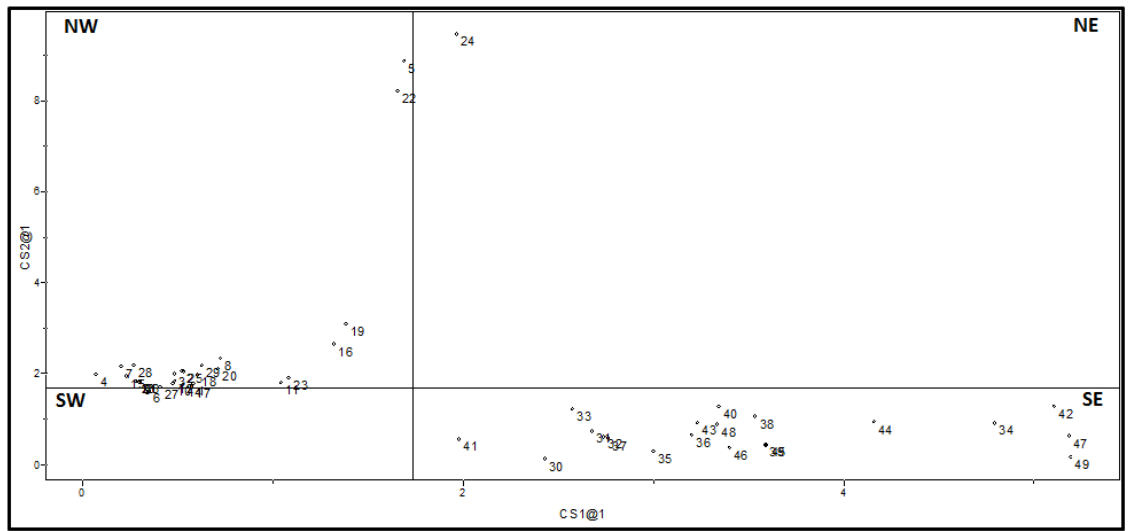
Figure 4. Class distances obtained for the 49 training set